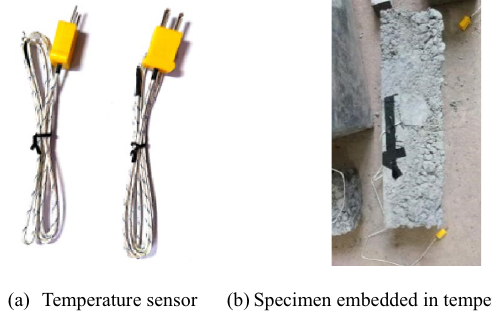
Figure 7. Temperature sensor and specimen to be tested.